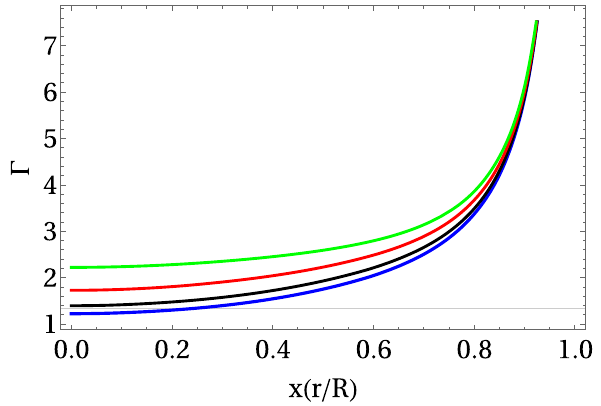
Fig. 19 (cid:16) forModelIIforcompactfactors:0.38(blueline),0.39(black line), 0.40 (red line) and 0.407 (green line). The horizontal line corre- spond to the value of